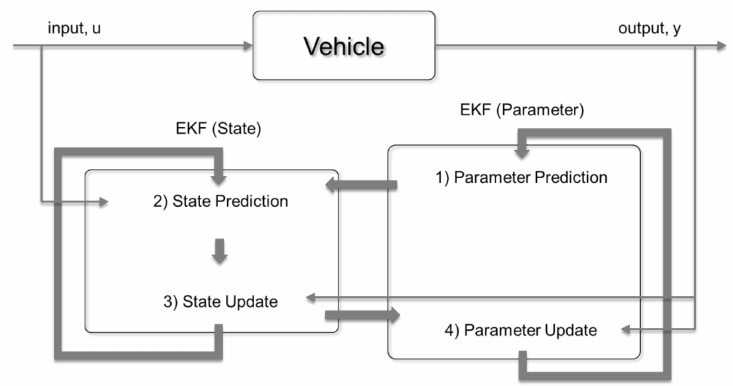
Figure 4. Scheme of dual-extended Kalman filter